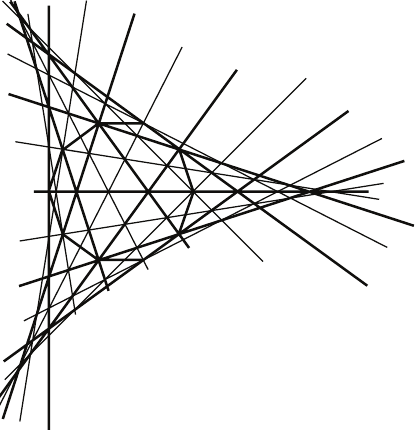
Figure 7: The 20-system with thick lines indicating flipped edges and the d (cid:5) 5 system.